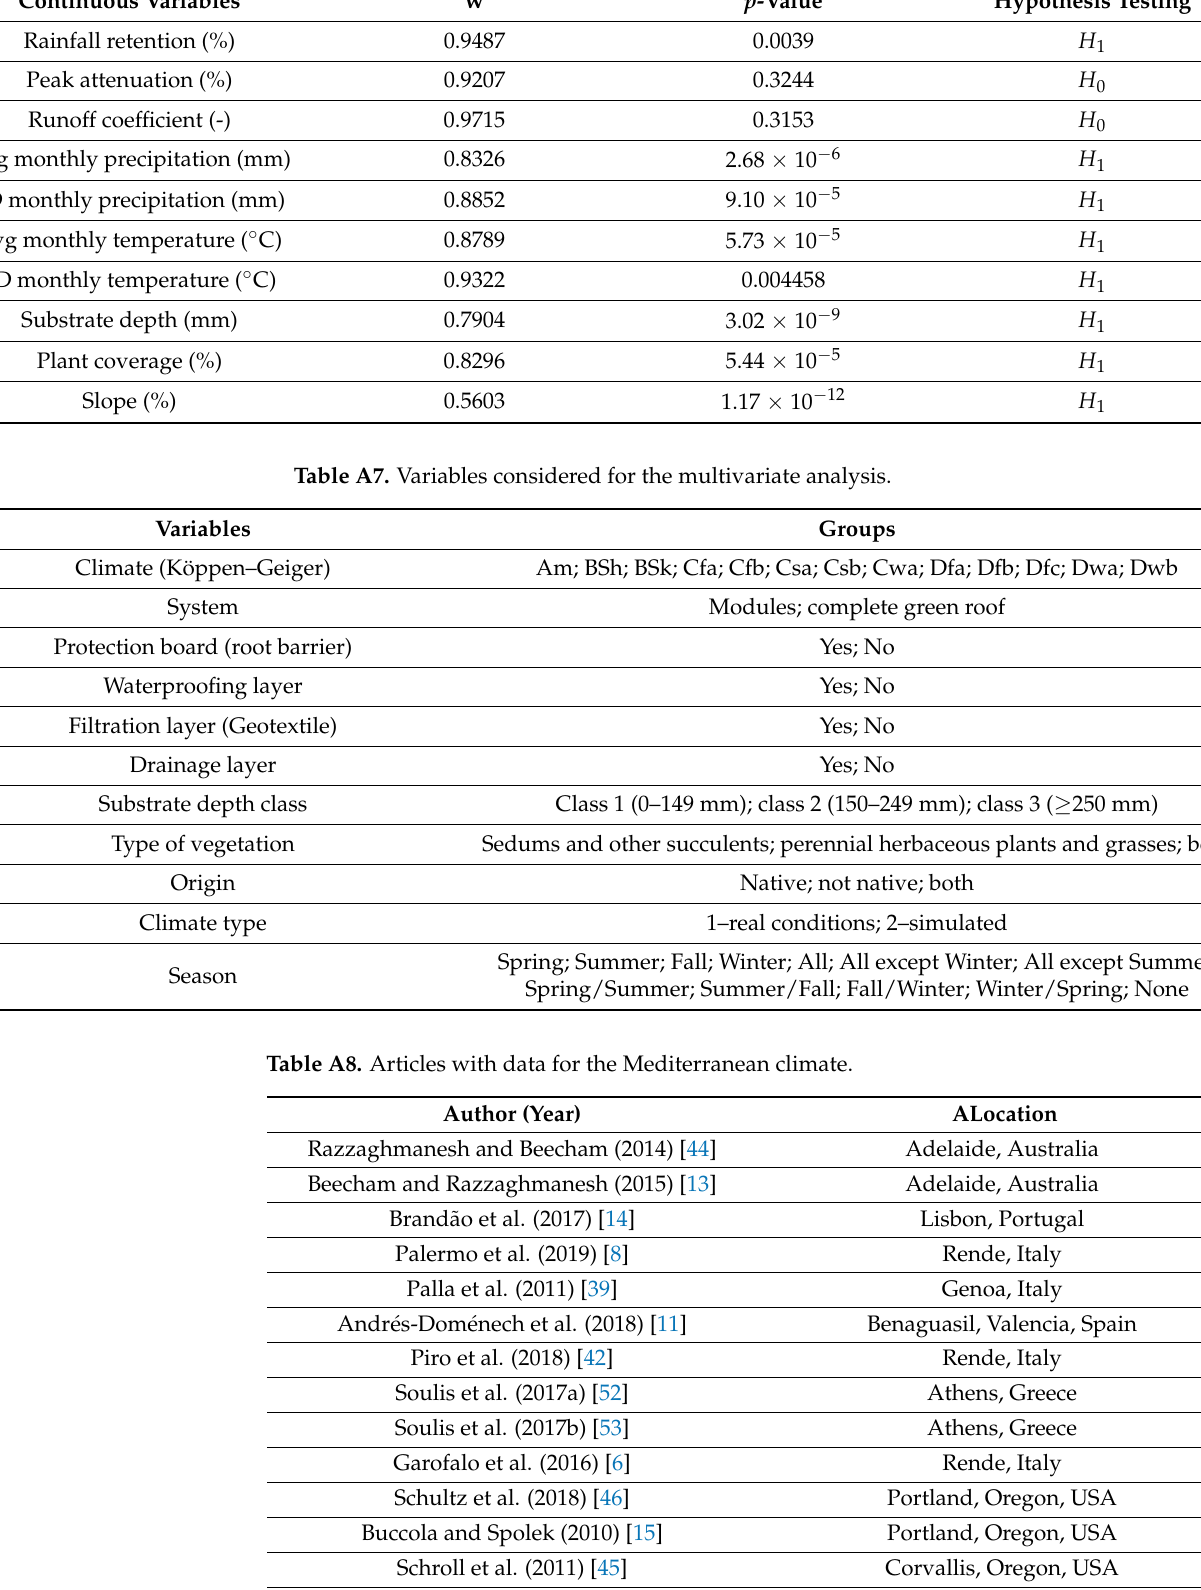
Table A6. Shapiro –Wilk test results for the continuous variables.